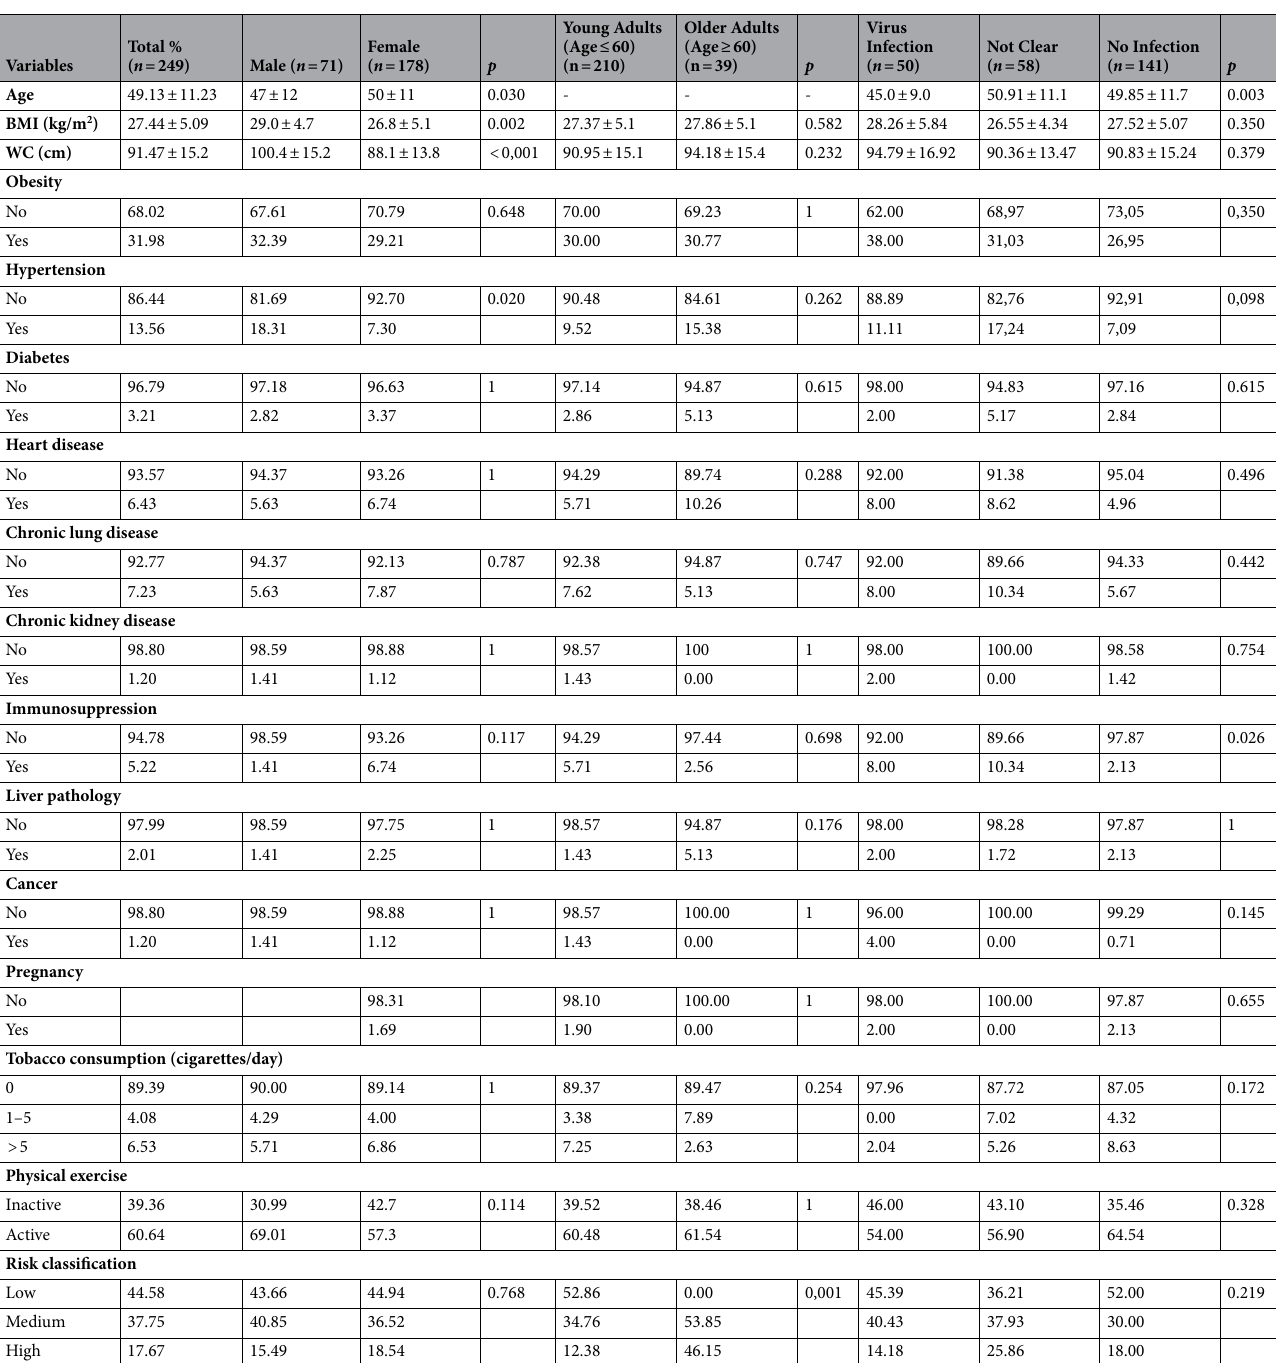
Table 1. Descriptive phenotypic and clinical data of the study sample categorized by gender, age and SARS- CoV-2 infection. Continuous variables: Mean ± SD. Categorical variables: %. BMI Body mass index. WC